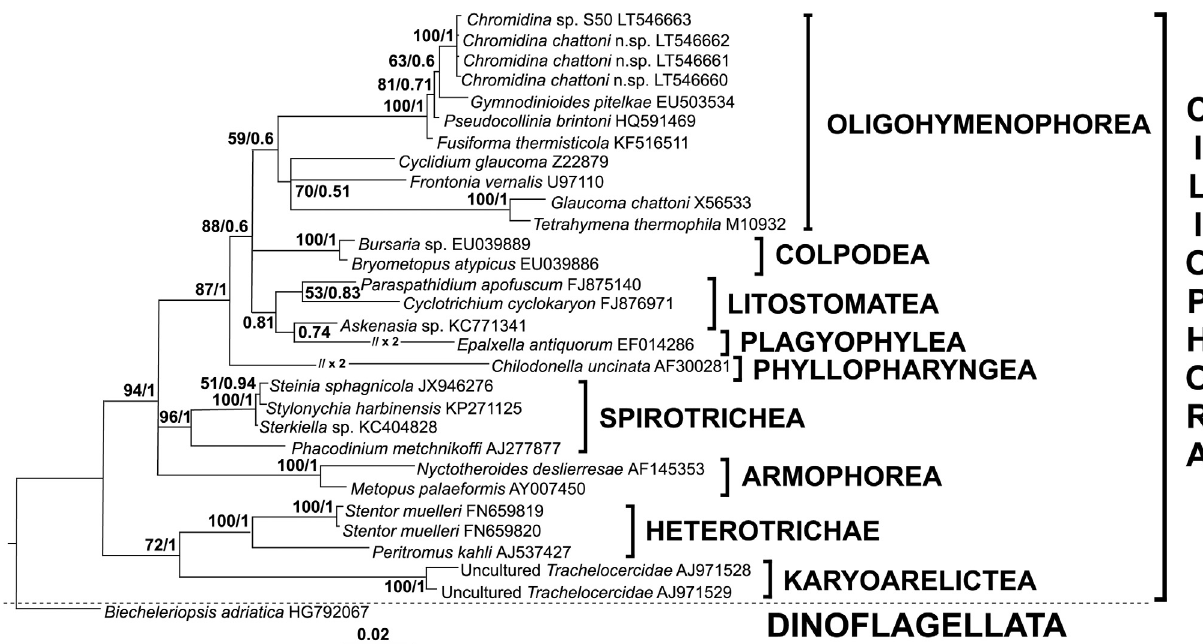
Figure 4. Phylogenetic position of Chromidina spp. within Ciliophora. This phylogenetic tree, rooted on a dinoflagellate rDNA sequence, was inferred from 30 small subunit (SSU) 18S rDNA sequences corresponding to the four Chromidina specimens identified in this study, 25 representatives of the major classes of the phylum Ciliophora, and one Dinoflagellata sequence taken as the outgroup. There were a total of 1,157 positions in the final dataset. Both the Maximum Likelihood (ML) method and Bayesian inferences, based on the general time- reversible +G +I model [28], were conducted and yielded similar topologies; the currently presented topology was obtained by the Bayesian inference. The tree is drawn to scale, with branch lengths measured in number of substitutions per site. Some branches were shortened by multiples of the length of substitutions/site scale bar (Plagyophylea, Phyllopharyngea). Numbers at the branches denote ML bootstrap percentage, from 1,000 resampling (first value) and Bayesian posterior probabilities (second